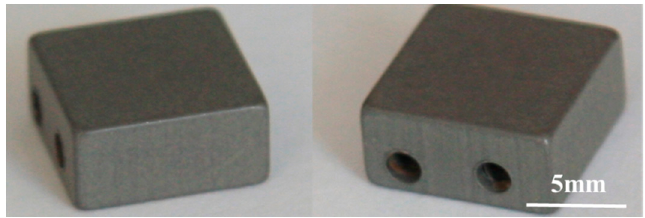
Figure 2. The Ti-6Al-4V block with MAO coating.